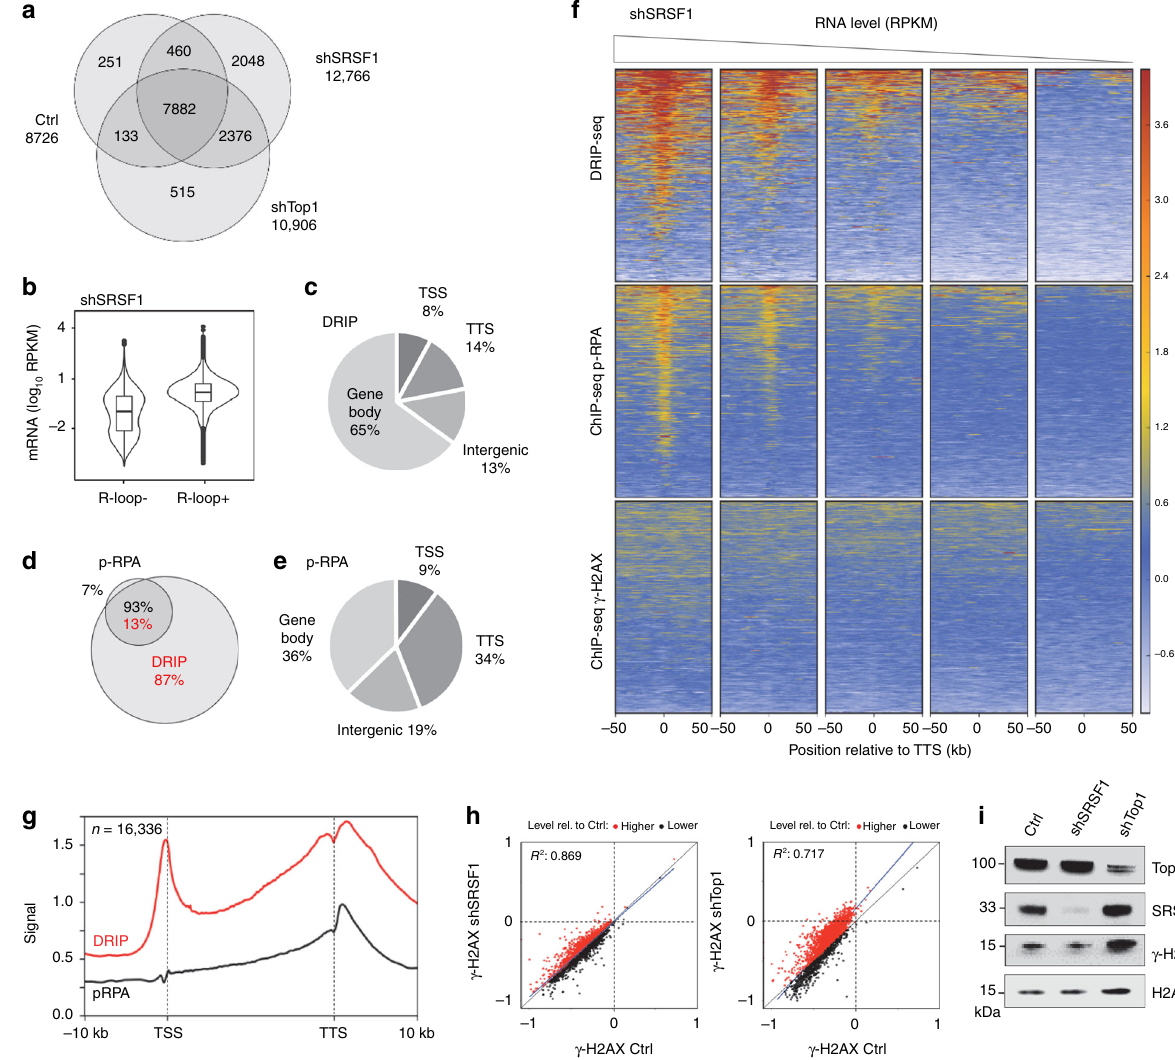
0.01.0 0.5 Fig. 4 Depletion of SRSF1 increases R-loop and p-RPA at TTS, but not γ -H2AX. a Venn diagram of the number of genes enriched in R-loops in control, shSRSF1, and shTop1 cells. R-loop-positive genes correspond to genes overlapping with R-loop peaks identi fi ed with MACS2. b mRNA level (RPKM) of genes overlapping (R-loop + ) or not (R-loop − ) with S9.6 peaks in shSRSF1 cells. Box: 25th and 75th percentiles; central line: median. c Distribution of R-loop peaks in shSRSF1 cells relative to gene annotations. Peaks were obtained with MACS2 and were analyzed with CEAS (Cis-Regulatory Element Annotation System). d Venn diagram of the percentage of genes overlapping with R-loop (red) and p-RPA peaks (black) peaks (MACS2) in shSRSF1 cells. e Distribution of p-RPA (S33) peaks in shSRSF1 cells relative to gene annotations. f Heat map of the intensity of RNA:DNA hybrids (DRIP), p-RPA, and γ -H2AX at TTS in shSRSF1 cells for fi ve groups of genes with decreasing mRNA levels (RPKM). Within each group, genes were sorted relative to the intensity of DRIP signal. g Metaplot of RNA:DNA hybrids (DRIP, red) and p-RPA (black) at 16,336 active genes in shSRSF1 cells. Error bars correspond to SEM. h Scatter plot of the intensity of γ -H2AX signal at all active genes in control, shSRSF1, and shTop1 cells. i Western blot analysis of γ -H2AX levels on chromatin in control, shSRSF1, and shTop1 cells. H2AX was used as a loading control ( n =